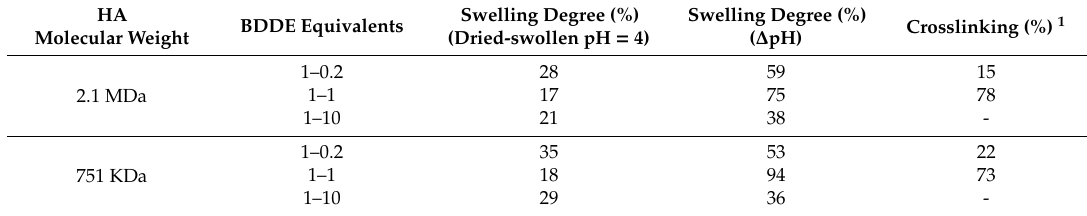
Table 1. Swelling degree (%) and crosslinking percentage of HA nanogels prepared with di ff erent initial molecular weights.